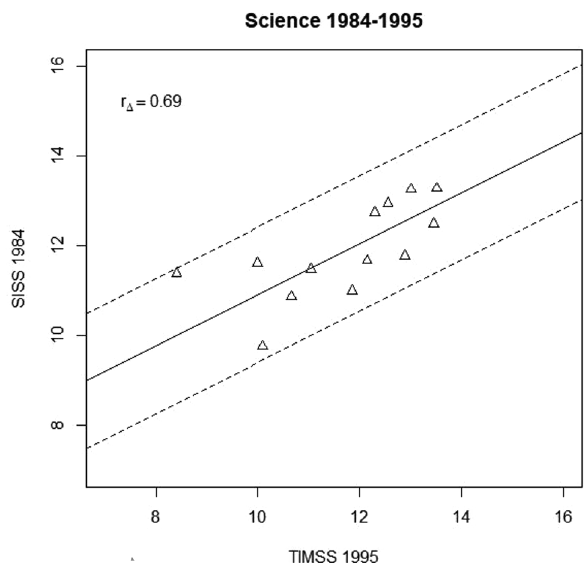
Fig. 8 Delta Plot of the bridge between SISS and TIMSS 1995